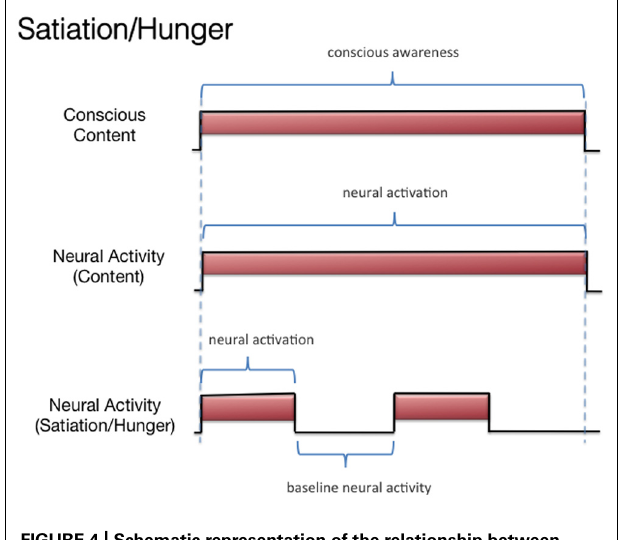
FIGURE 4 | Schematic representation of the relationship between subjective olfactory experience and hypothetical neural activity, under conditions of hunger and